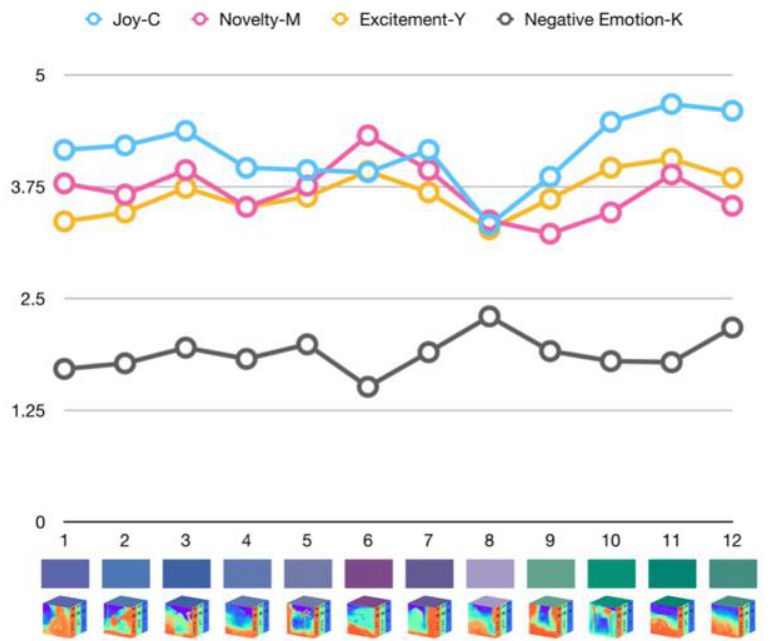
Figure 10. Result of emotion questionnaire and the colour definition of visualisation.